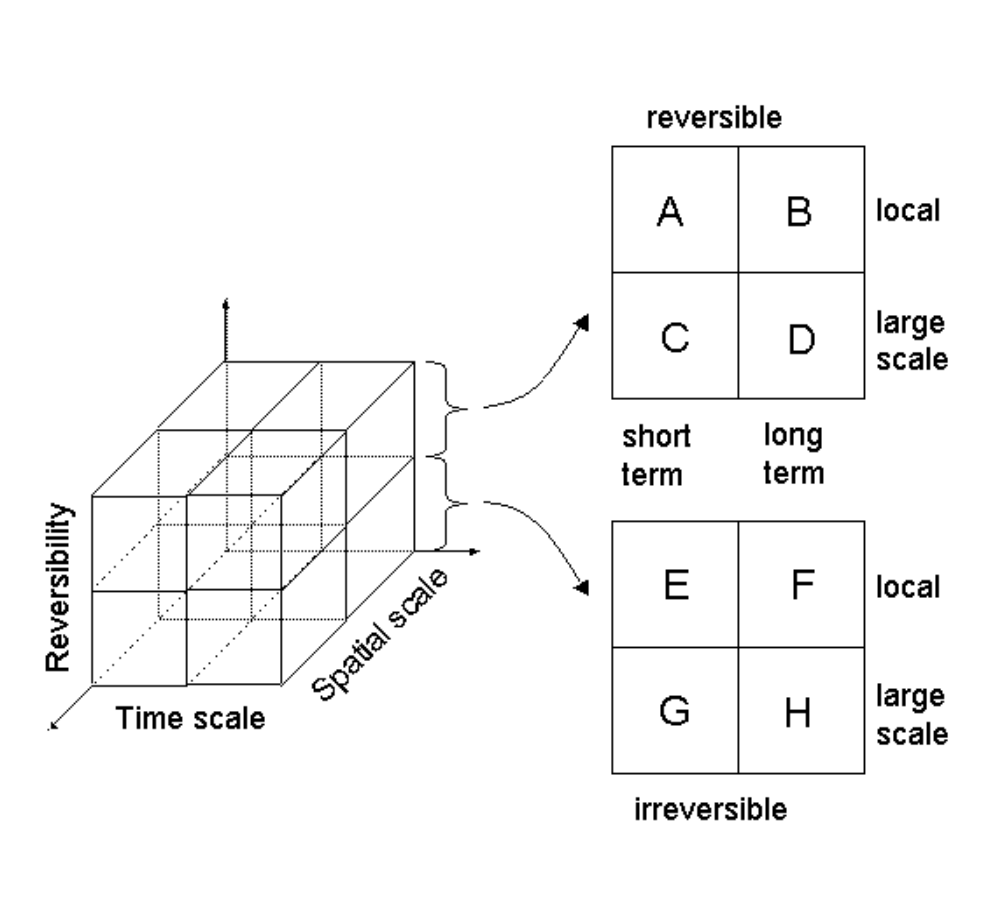
Fig. 2. Eight categories of ecosystem service trade-offs, classified according to their spatial and temporal scales, and their degree of reversibility (Excerpted from Millennium Ecosystem Assessment. 2005. Ecosystems and Human Well-Being: Scenarios, Volume 2 . Copyright © 2005 by the author. Reproduced by permission of Island Press, Washington,